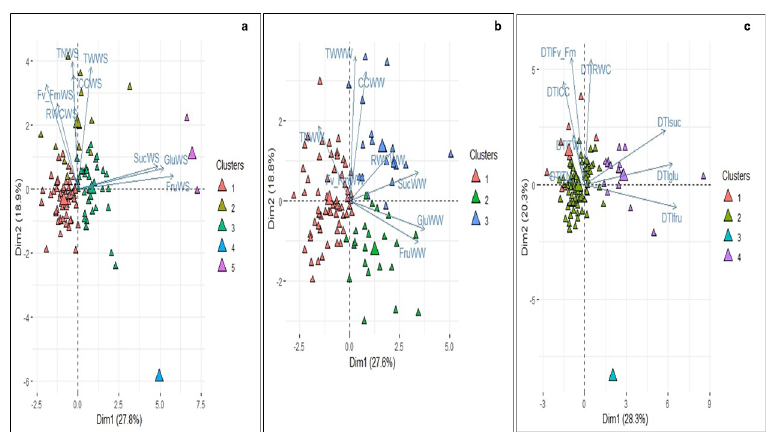
Fig 3. Principal component analysis biplot with clusters defined from physiological, biochemical and yield- related variables of a diversity panel of Solanum tuberosum group Phureja genotypes grouping. a.) water deficit conditions, b.) well-watered conditions and c.) drought stress index (DTI). The axes present the percentage of variance accounted in the first two principal components. The color of triangles represents the 104 genotypes from the Work Collection of Potato Breeding program at the Universidad Nacional de Colombia and denote the clusters from genotypes. Sucrose content (Suc), Glucose content (Glc), Fructose content (Fru), the maximum quantum efficiency of PSII (F v /F m ), the relative chlorophyll content (CC), tuber number (TN), tuber fresh weight per plant (TW) and relative water content